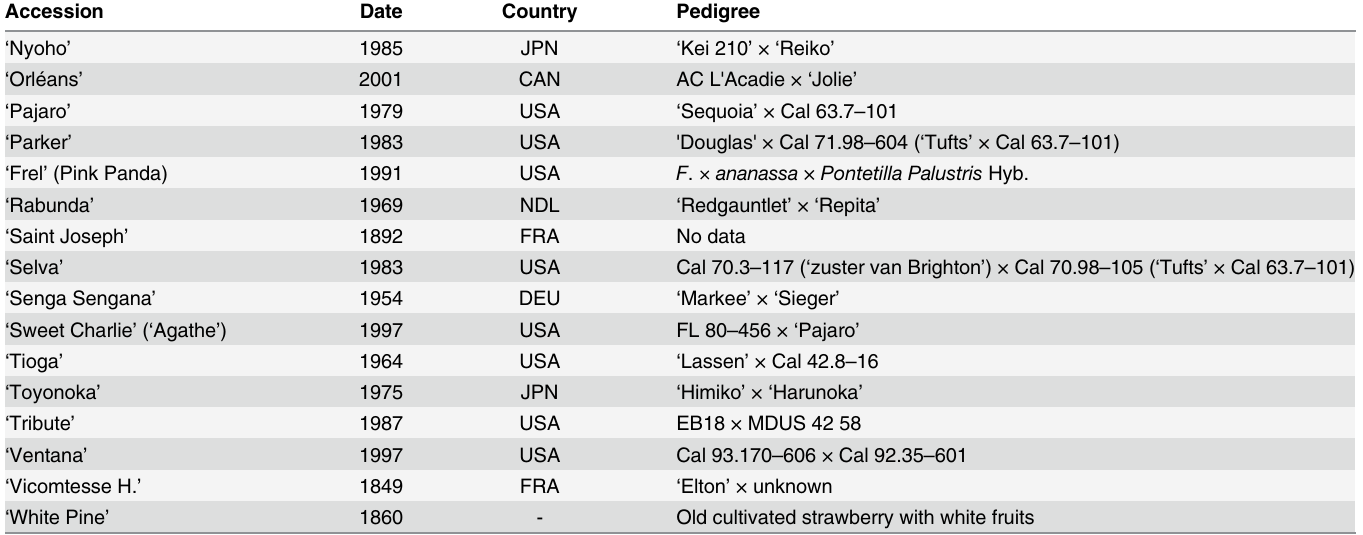
about each accession is publicly available at the European GENBERRY database